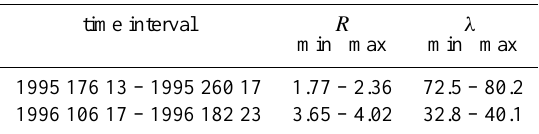
Table 1. Start and end times (year, day, hour), minimum and max- imum distances ( R , in AU), and latitudes ( λ , in degrees, northern hemisphere) of the core (first row) and boundary (second row) in- terval.